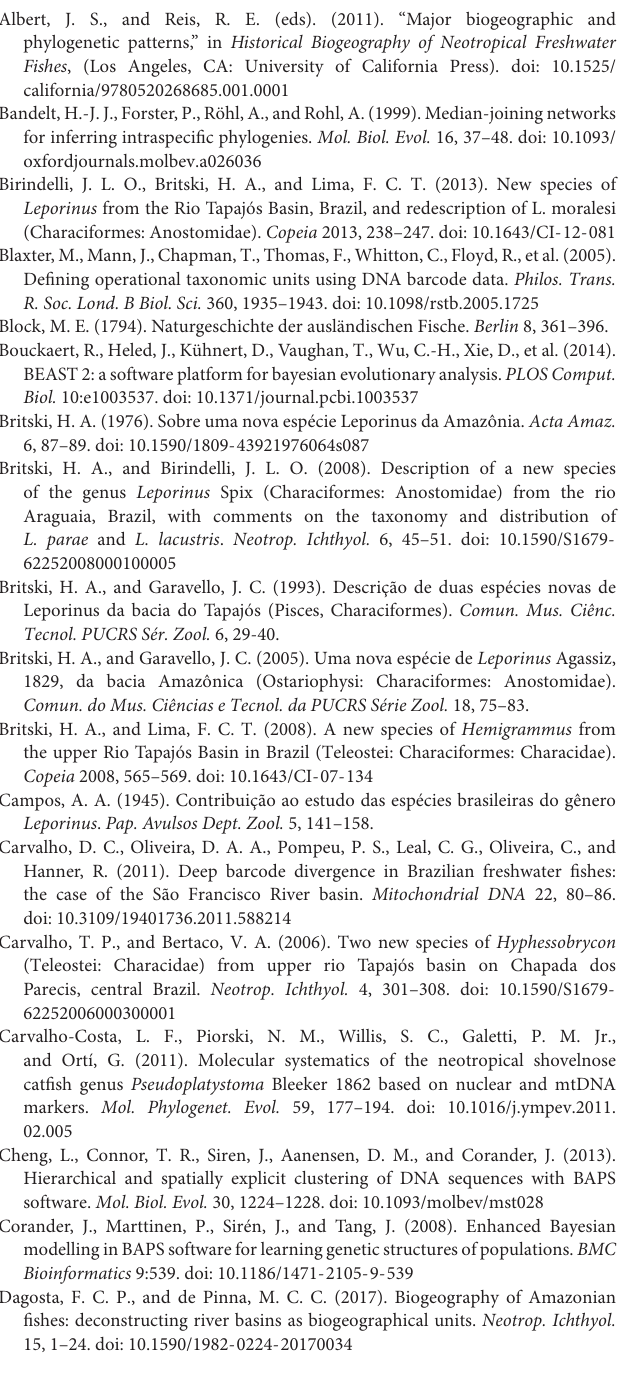
FIGURE S3 | Bayesian tree for the myosin heavy chain 6 cardiac muscle alpha (Myh6) gene. Values on nodes represent the posterior probability. FiGURE S4 | Bayesian tree for the recombination activating gene 1 (RAG1) gene. Values on nodes represent the posterior probability. FiGURE S5 | Bayesian tree for the recombination activating gene 2 (RAG2) gene. Values on nodes represent the posterior probability.